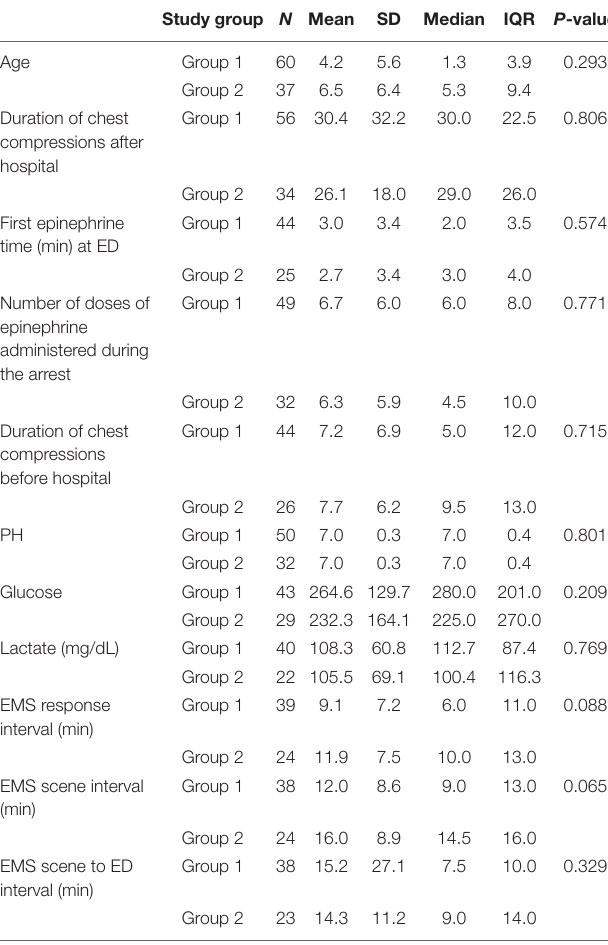
frame of emergency response system (min) based on before or after the